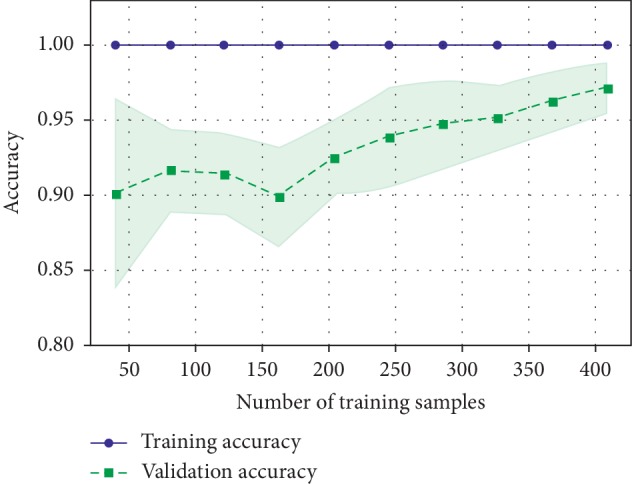
Validation accuracy.